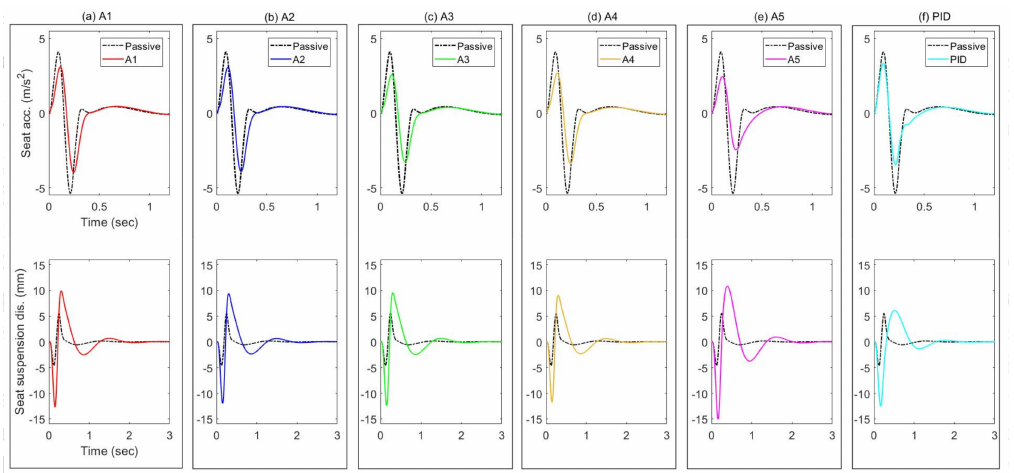
Figure 9. Simulated seat suspension performance of the passive and active systems when subject to a bump road input. ( a ) A1; ( b ) A2; ( c ) A3; ( d ) A4; ( e ) A5; ( f )